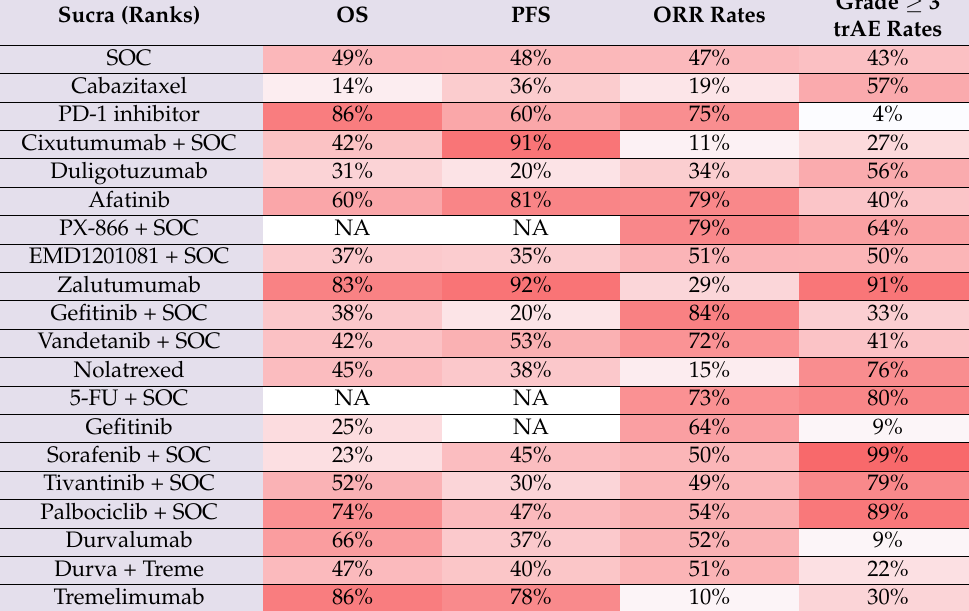
Table 2. The summarized SUCRA (ranks) with respect to the effectiveness and toxicity of each treatment. SUCRA values near to 1 entail the best treatment with respect to OS, PFS, and OR. SUCRA values near to 0 entail the best treatment with respect to grade ≥ 3 trAE. SOC = standard of care (docetaxel, methotrexate, or cetuximab). The darker the color represented higher probability. Sucra (Ranks)